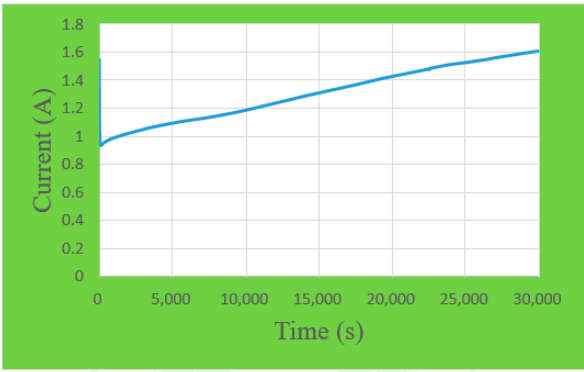
Figure 6. Activation curve diagram of the proton exchange membrane water electrolyzer.